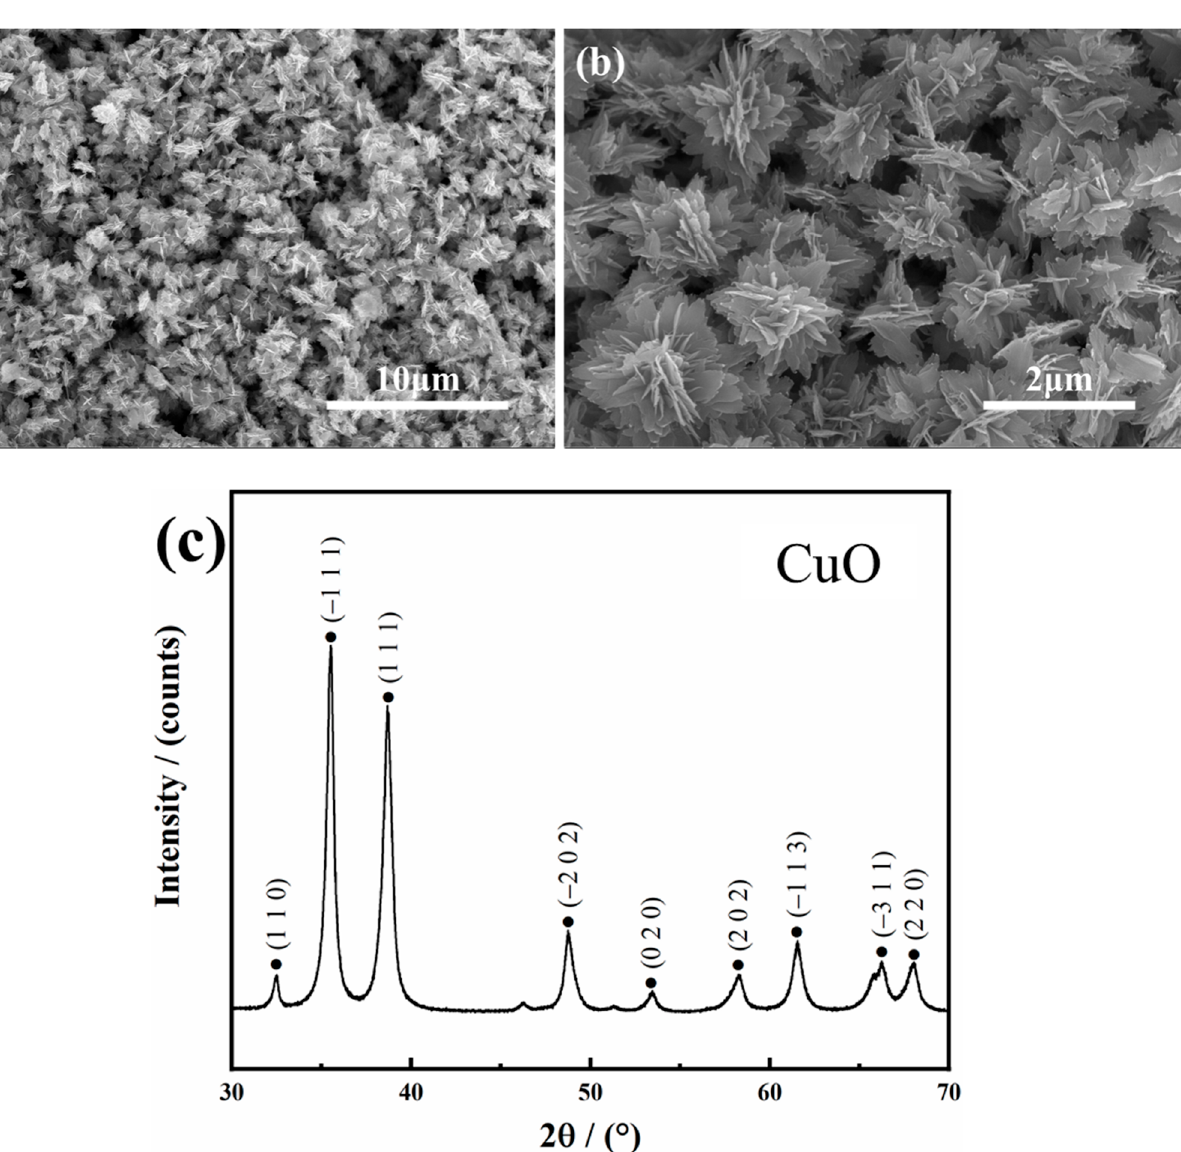
Figure 3. The CuO nanoparticles. ( a ) SEM image with low magnification, ( b ) SEM image with high magnification and ( c ) X-ray diffraction pattern.